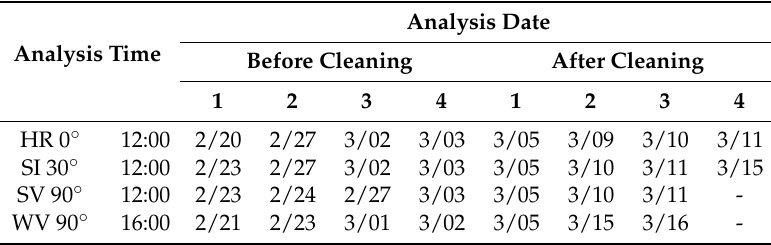
Table 5. Analysis date and time about array cleaning